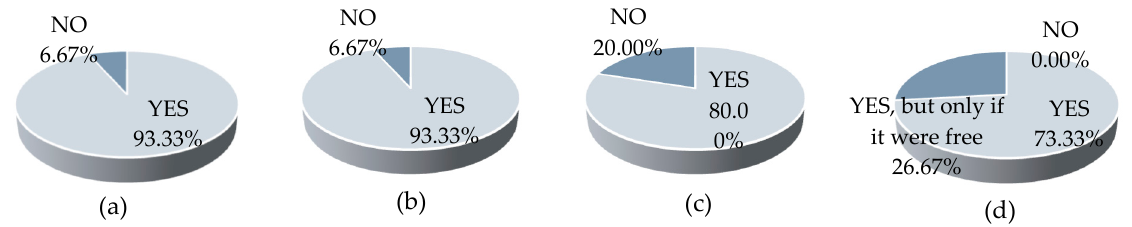
Figure 5. Responses to the questions: ( a ) “Do you think that people responsible for HS on construction sites should use BIM for HS hazard detection?” ( b ) “Do you think that increasing the efficiency of hazard detection would directly increase the usage of BIM for hazard detection by those responsible?” ( c ) “Do you think that an increase in hazard detection efficiency would directly increase the HS level on the construction site? ( d ) “If there were a tool for automatic hazard detection in BIM, would you use it?”